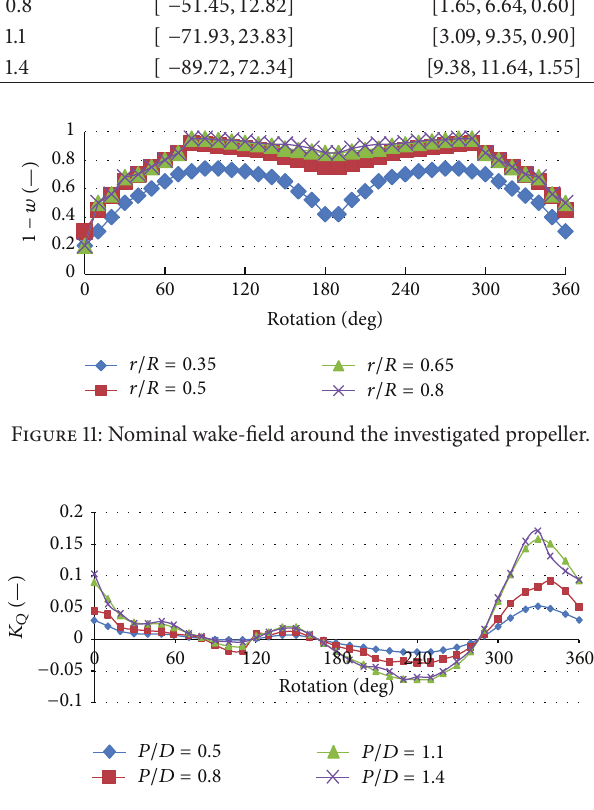
Figure 12: Spindle torque of the propeller during one revolution.